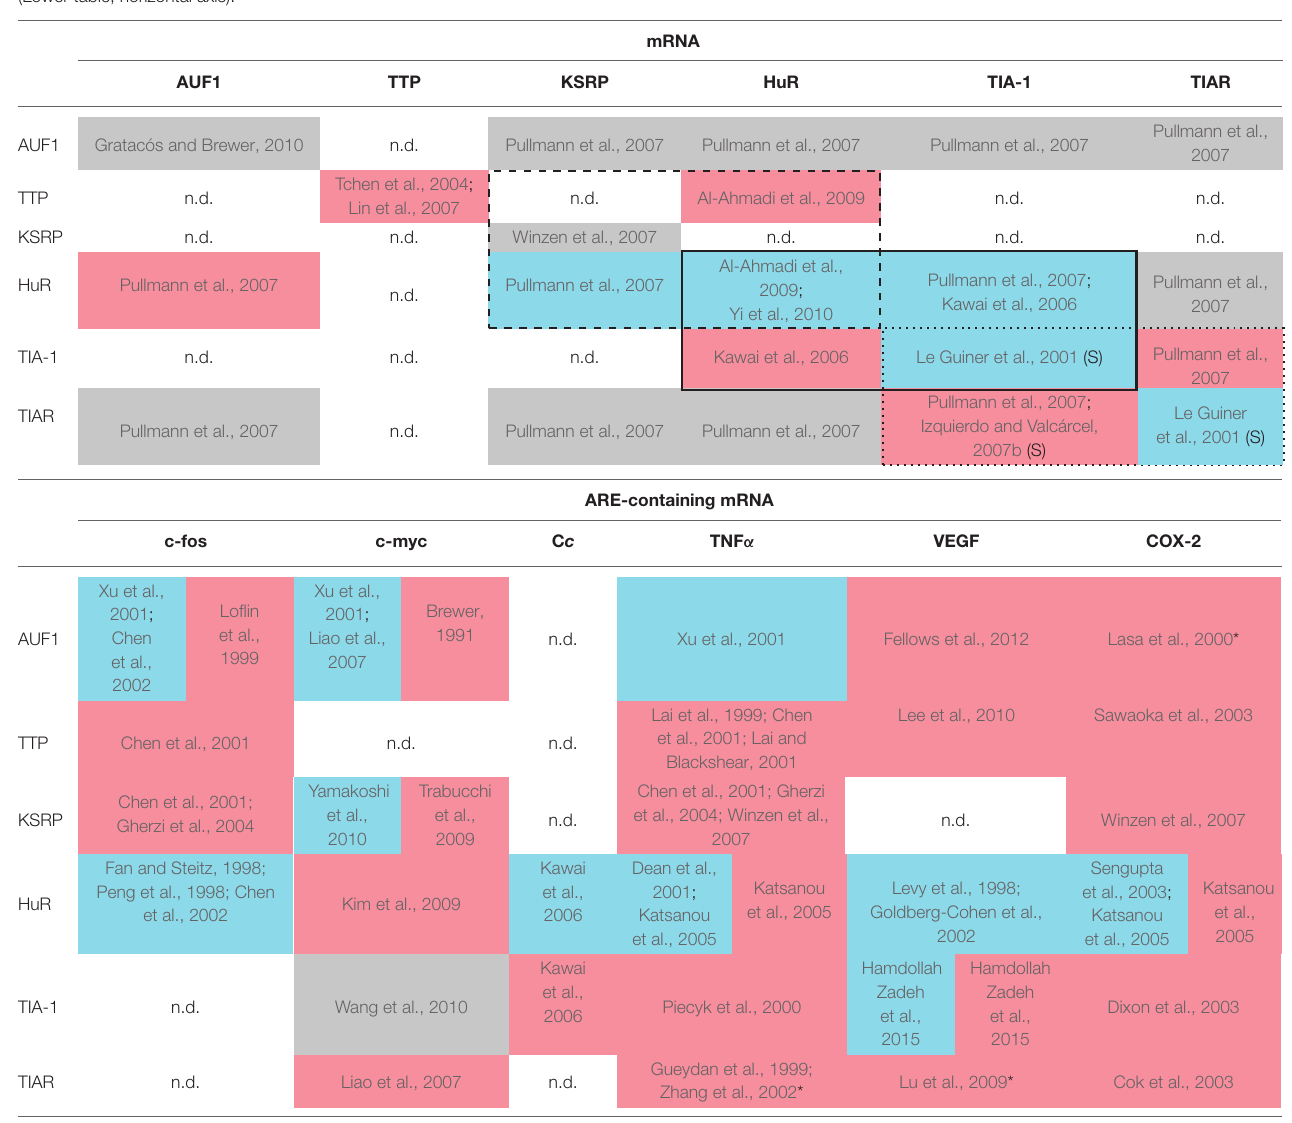
TABLE 1 | Matrix representation of the interaction of selected RBPs (vertical axis) with the mRNA of those RBPs (Upper table) and several ARE-containing mRNA targets (Lower table, horizontal axis).